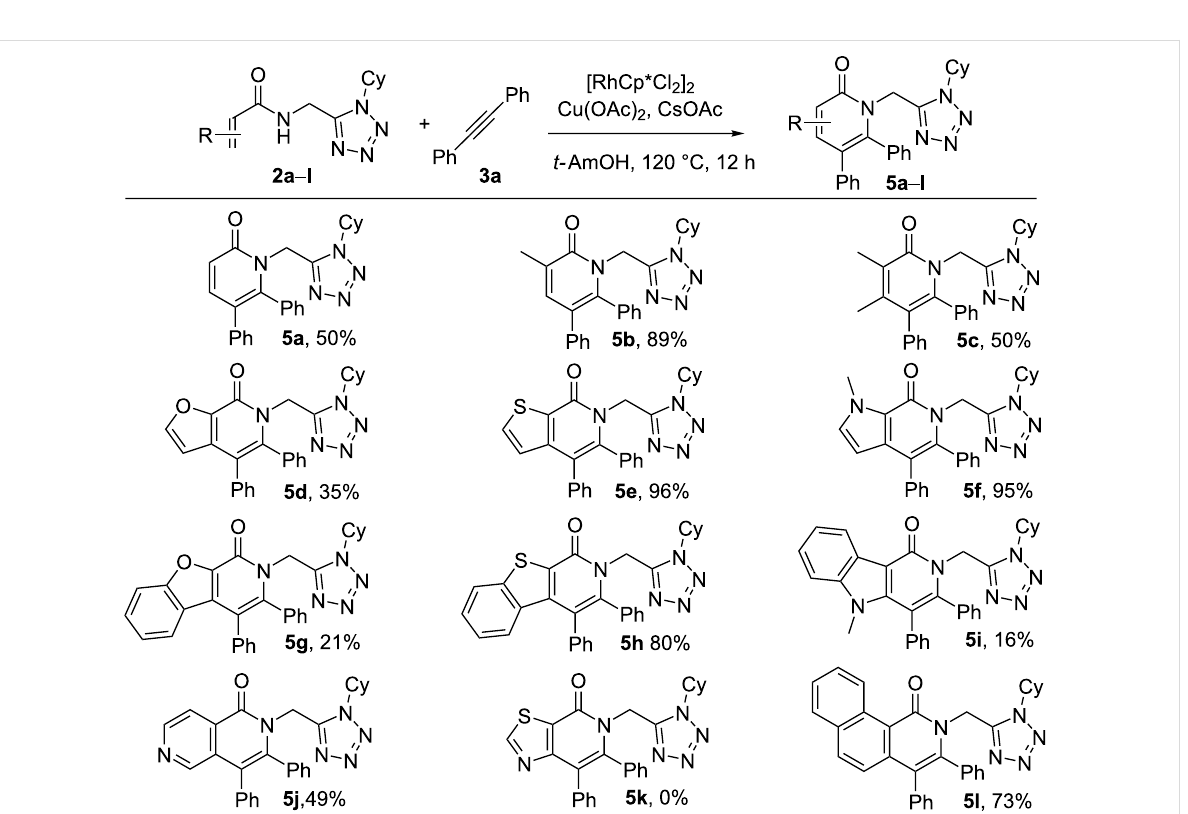
Scheme 4: Influence of the alkyne and R 1 substituent on the reaction outcome.